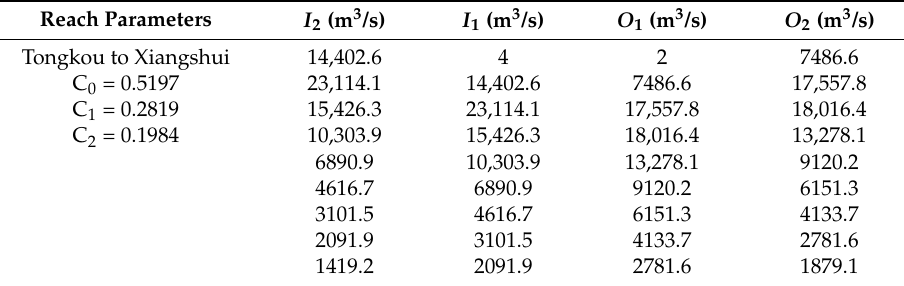
Table 7. Muskingum flood routing between Tongkou and Xiangshui.